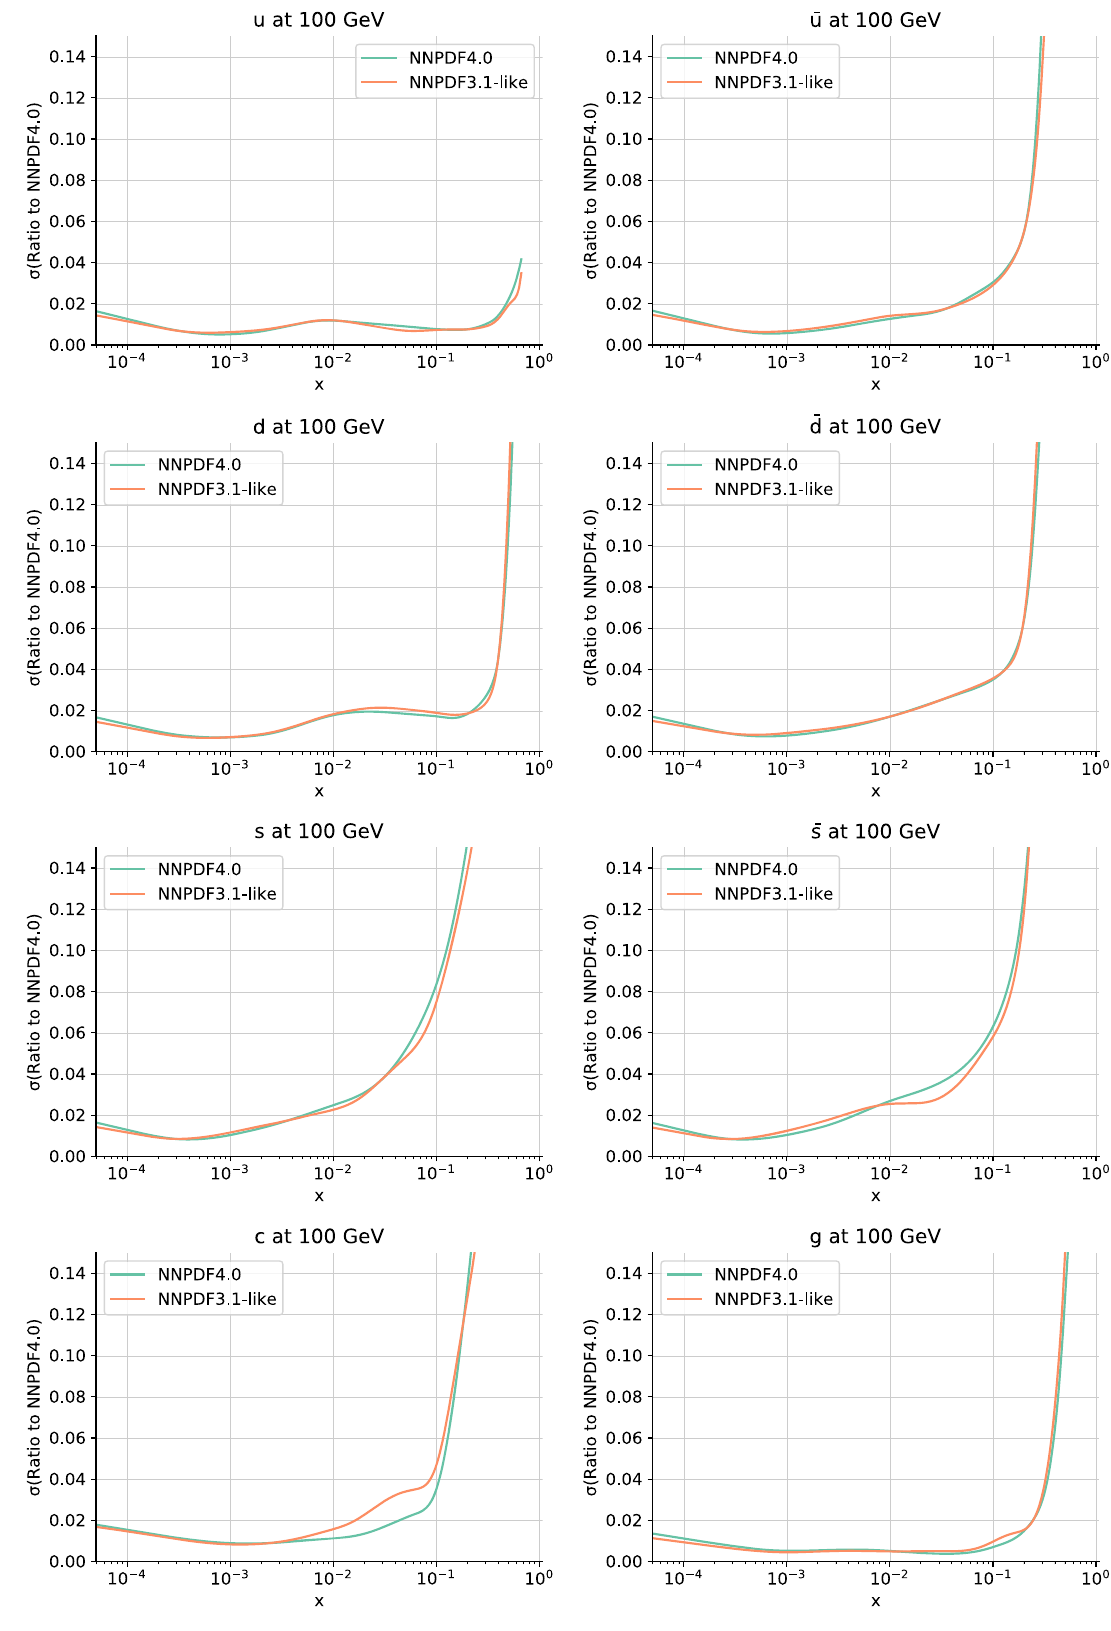
Fig. 34 Same as Fig. 33 but for one-sigma relative